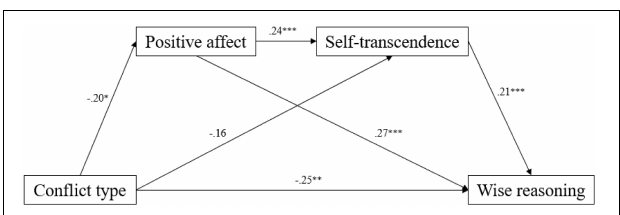
FIGURE 2 | The sequential mediation of mood and self-transcendence. * p < 0.05, ** p < 0.01.